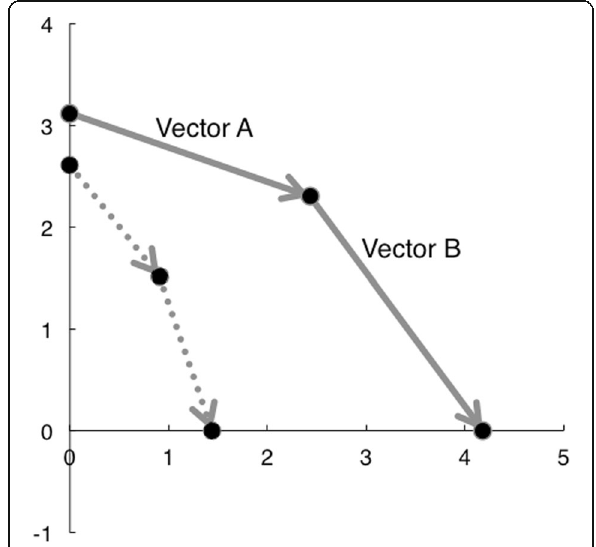
Fig. 2 Superimposed graphic vector representations of maxillary molars in the FM and pseudo-III groups. Solid line: FM group; broken line: pseudo-III group. Vector A: maxillary skeletal growth component; vector B: maxillary dental component. The functional occlusal plane, a line drawn through the occlusal surfaces of the maxillary and mandibular first molars and first and second deciduous molars, of the T2 cephalogram was used as the x -axis for the sagittal